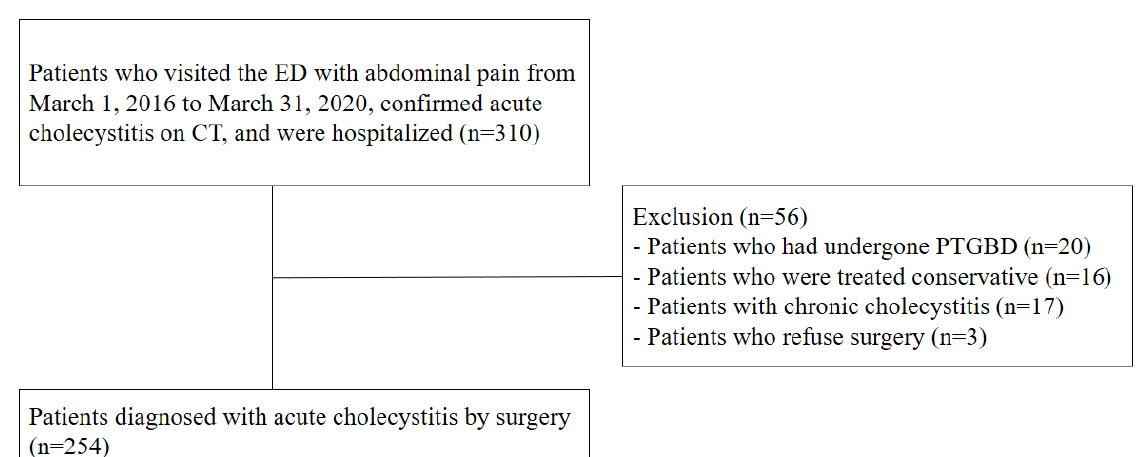
Figure 1. Patient populations with acute cholecystitis. Abbreviations: ED, emergency department; CT, computed tomography; PTGBD, percutaneous transhepatic gallbladder biliary drainage. A total of 254 consecutive patients who visited the ED for right upper quadrant pain